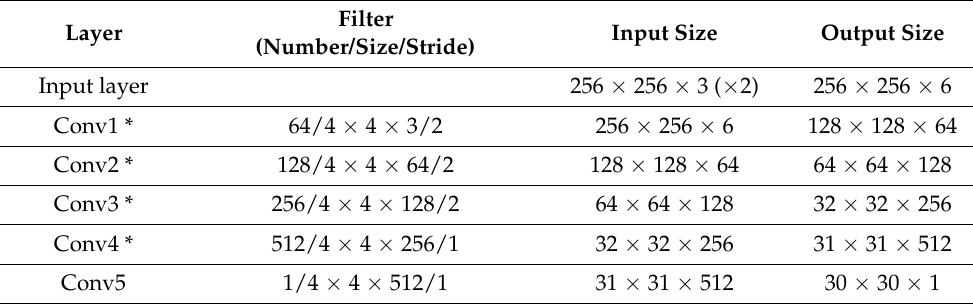
Table 1. Architecture of the discriminator used in